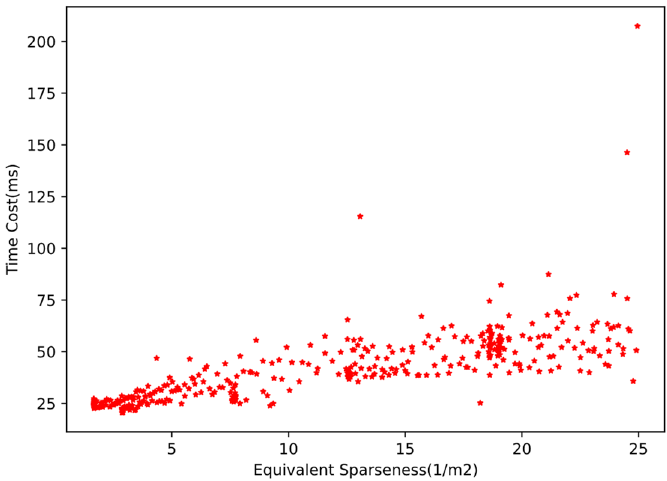
Figure 19. The calculation time cost distribution of ECPC-ICP of 𝑺′ from 0 to 25. Table 5. The statistical results of ECPC-ICP time cost and the preprocessing and segmentation module time cost.